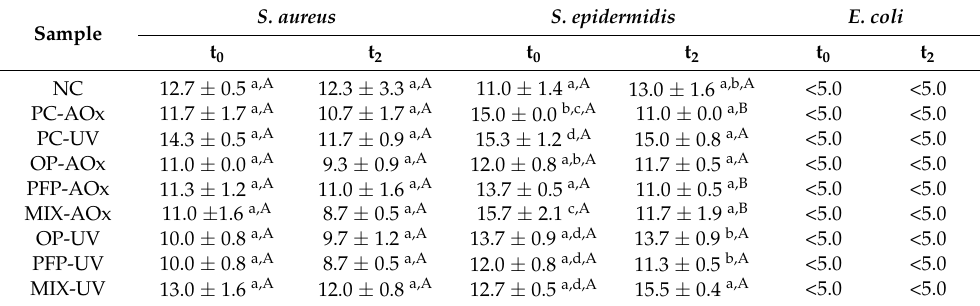
Table 4. Antibacterial capacity, represented through the diameter of the inhibition halo in mm, of the formulations against S. aureus , S. epidermidis and E. coli for t 0 and t 2 .